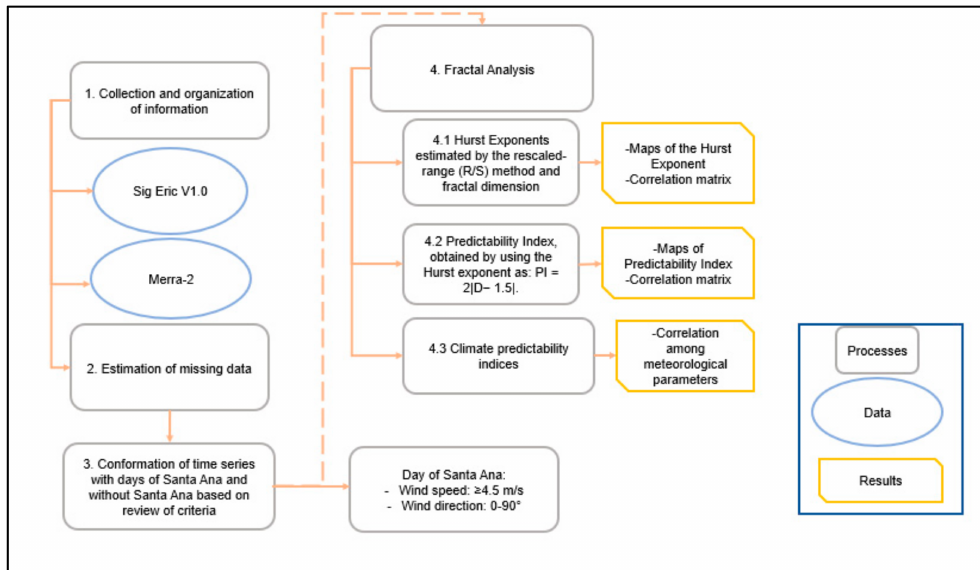
Figure 2. Methodology